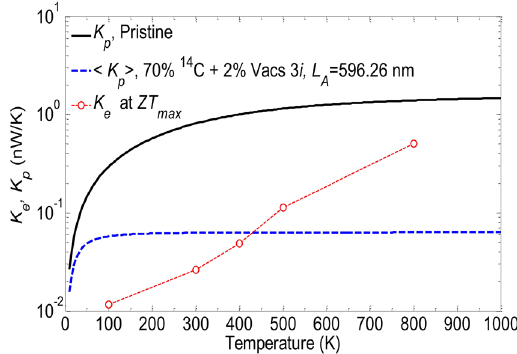
Figure 9. Comparison between the phonon and electron thermal conductances at positions of ZT max for different temperatures. Data provided for M = 5 and N A = 1400 ( L A = 596.26 nm) nanoribbons.